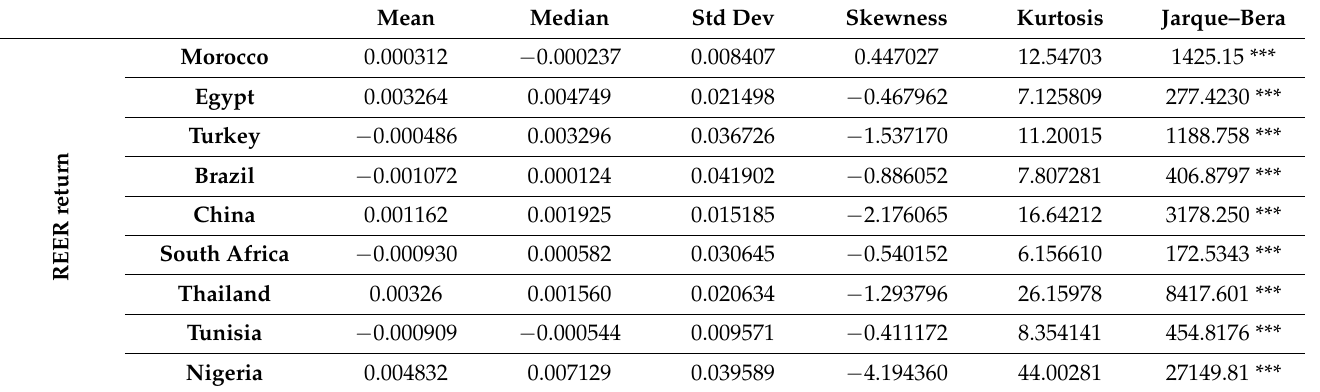
Table 3. Descriptive statistics of the REER return